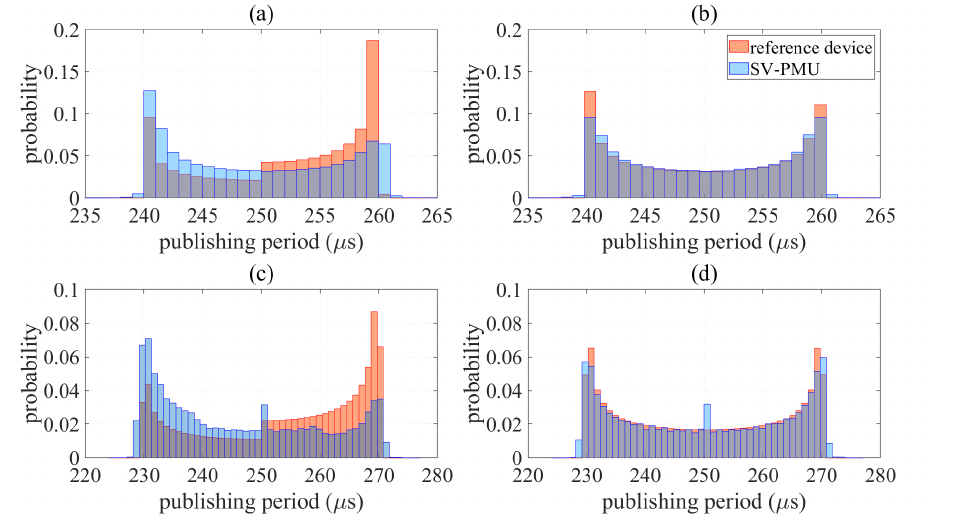
Figure 3. Distribution of published (orange) and received (blue) SV, with a sinusoidal deviation with regard to nominal publishing period of 250 µ s realized with the following amplitude and frequency parameters: ( a ) A = 20 µ s and f = 6 Hz, ( b ) A = 20 µ s and f = 4 Hz, ( c ) A = 10 µ s and f = 6 Hz and ( d ) A = 10 µ s and f = 4